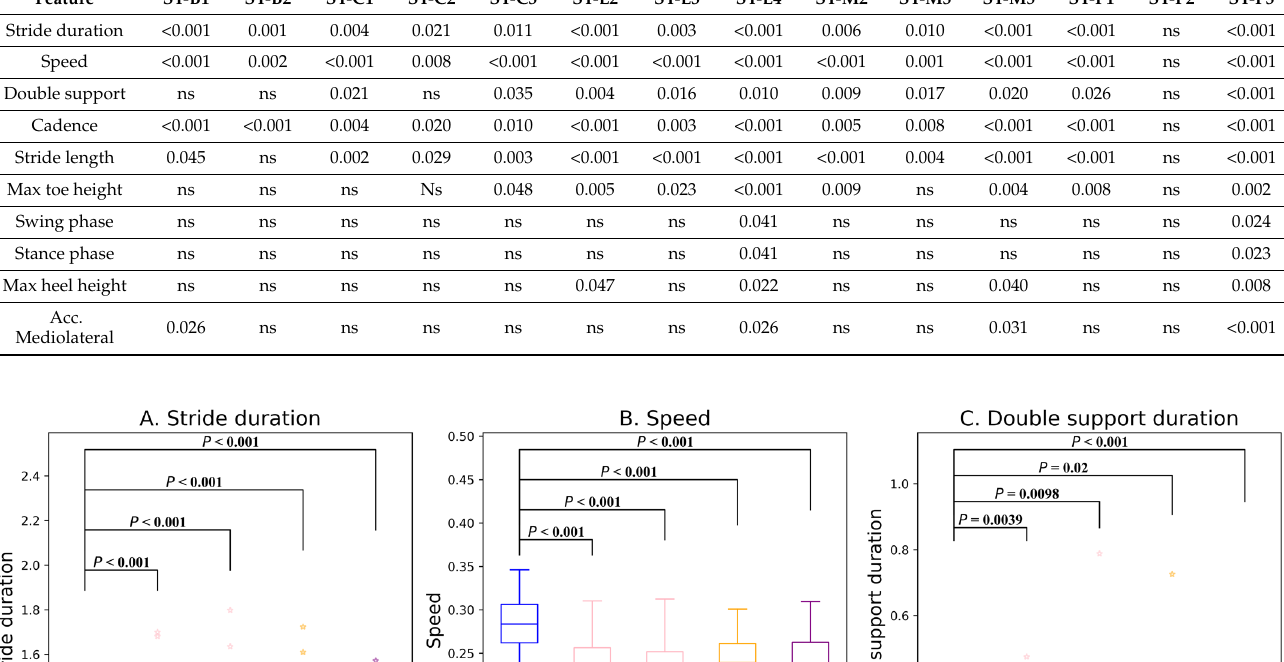
Table 5. Results of applying the t -test of each dual-tasking task vs. single-task gait for each normal- ized gait parameter.